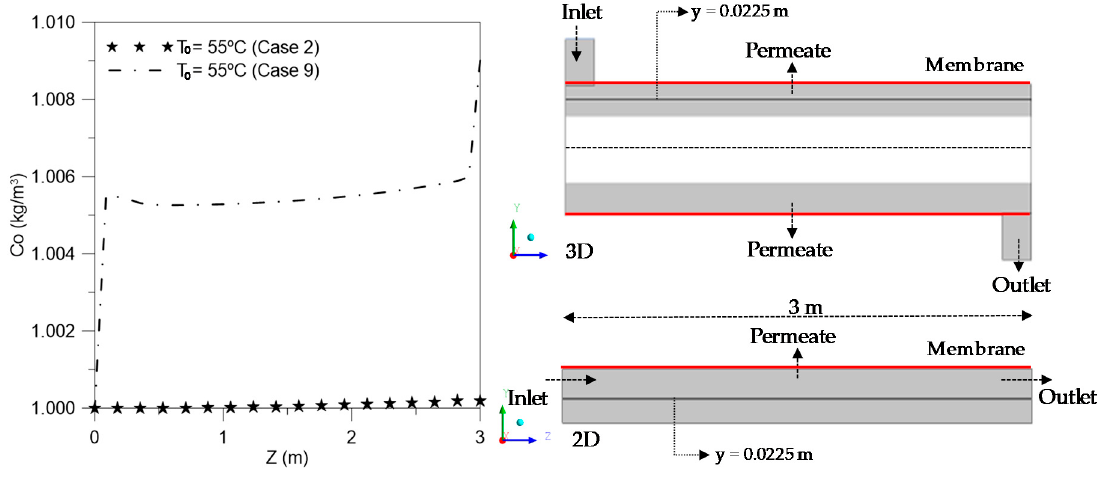
Figure 5. Oil concentration profile along the z-axis, in y = 0.0225 m (Cases 2 and 9).